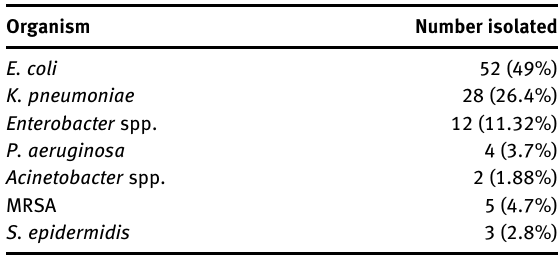
Figure 3: Distribution of isolates in neonatal septicemia in our study. Table  : List of Gram-negative organism isolated from study group organism.